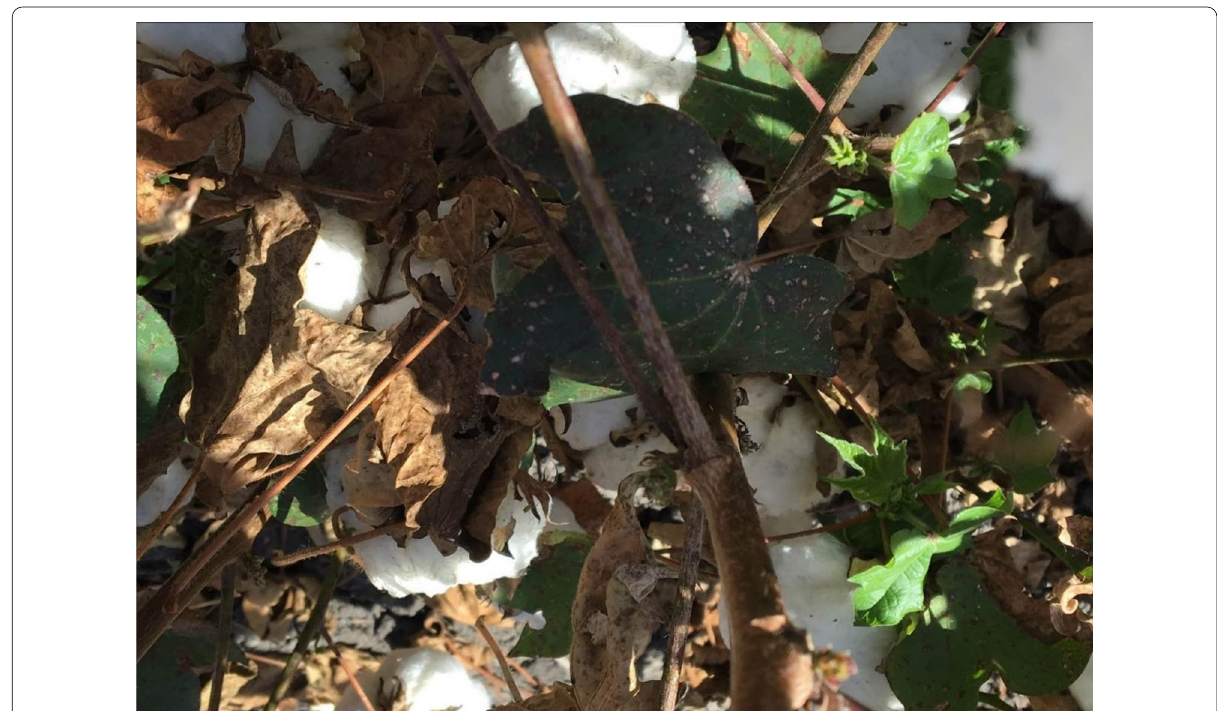
Fig. 3 Defoliated leaf caught in canopy (courtesy van der Sluijs, Marinus H.